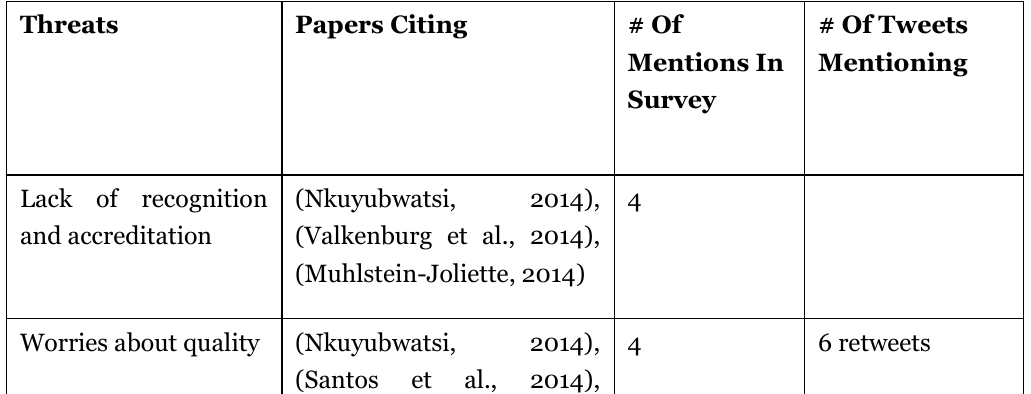
Threats on Macro